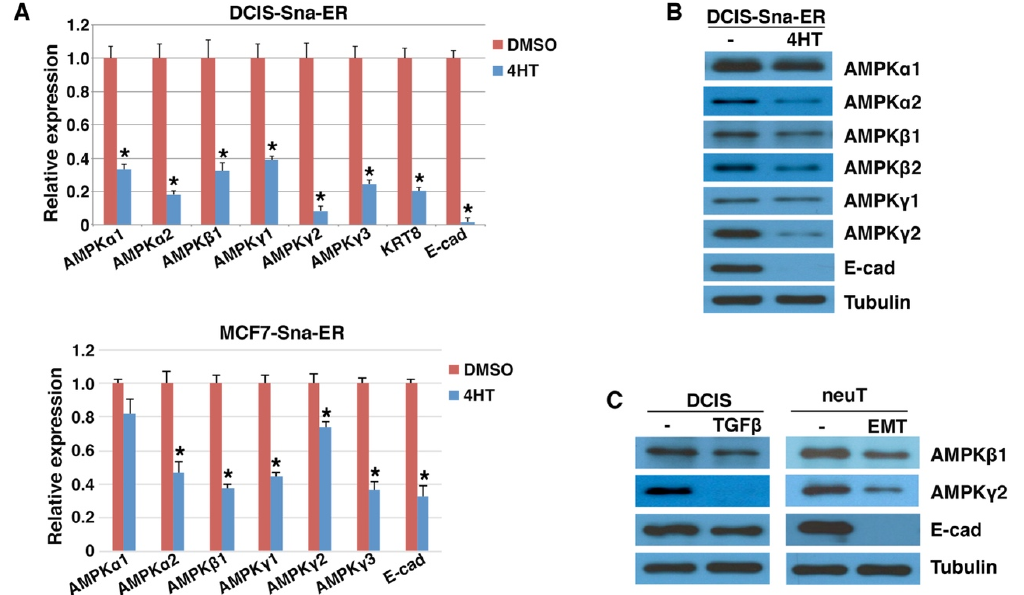
Figure 2. Downregulation of AMPK genes by EMT. ( A ) DCIS-Snai1-ER and MCF7-Snai1-ER human breast cancer cells were treated with vehicle (DMSO) or 4HT for 2 days, followed by quantitative RT-PCR analysis for AMPK genes (normalized by β -actin). Epithelial markers E-cadherin (E-cad) and keratin (KRT8) served as positive controls. Data shown as mean ± S.D. * p < 0.05. ( B ) Human DCIS-Snai1-ER cells were treated with DMSO or 4HT for 2 days, and subjected to immunoblotting with indicated antibodies. ( C ) DCIS breast epithelial cancer (±TGF β for 2 days) and mouse neuT and neuTemt mammary tumor cells were immunoblotted with indicated antibodies. Tubulin was used as loading control.